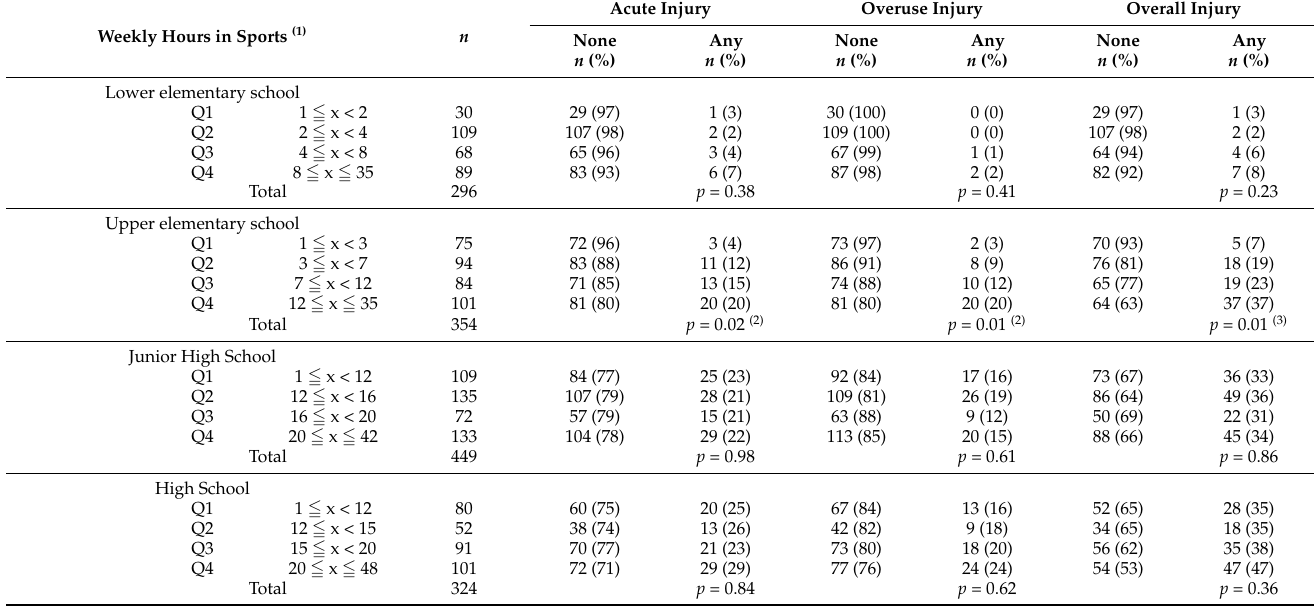
Table 3. The number and proportion of participants with sports-related injuries according to weekly hours in